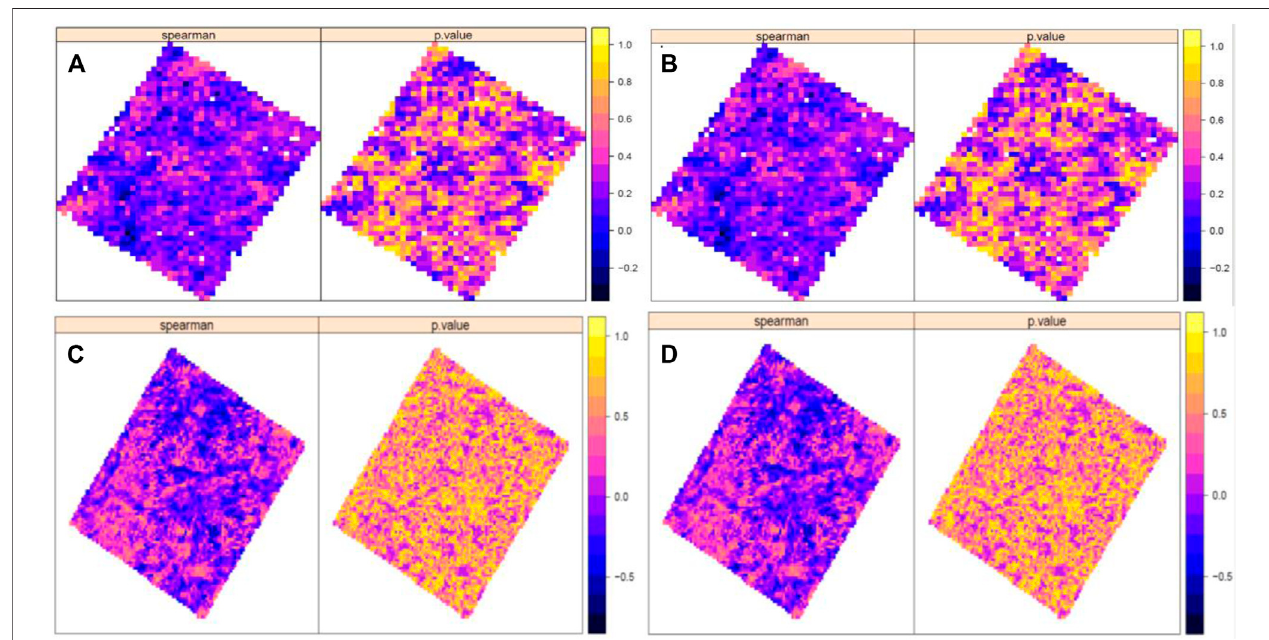
FIGURE 8 | Correlation coef fi cient and its signi fi cance testing results between vegetation GPP, NDVI, and climate factors [ (A) between GPP and precipitation; (B) between GPP and temperature; (C) between NDVI and precipitation; and (D) between NDVI and temperature].